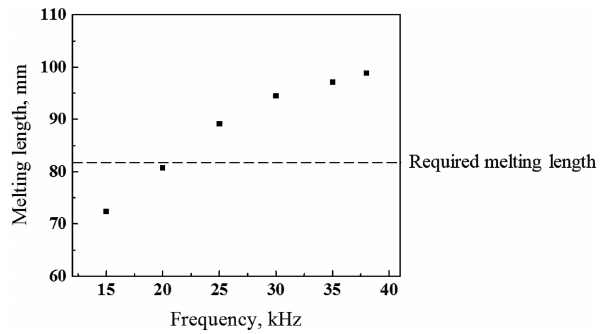
Figure 3: Effect of frequency on the melting length of the Fe-C